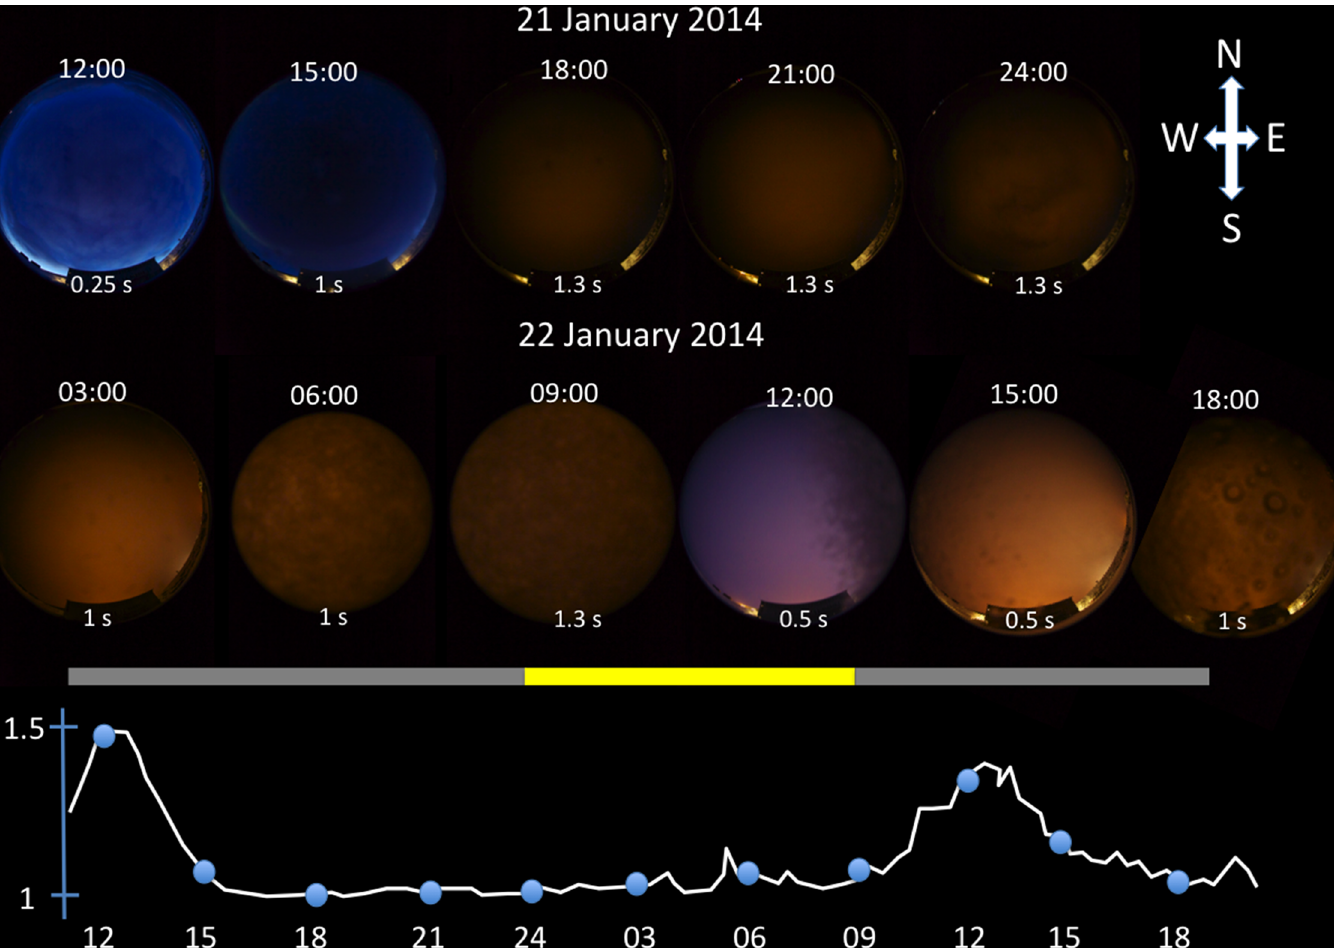
Fig 1. All-sky pictures from Ny- Å lesund 21st and 22nd of January 2014. Time of day is indicated on each picture and corresponds to a blue circle on the graph (bottom; E PAR , 400 – 700 nm, Photosynthetic Active Radiation) showing the absolute value of ambient light at that point in time in units of x10 -5 μ mol photons m -2 s -1 . The rectangular bar indicates the time of day when the moon is below (grey) and above (yellow) the horizon, and aligned with the time-scale on the irradiance graph below. On each picture the exposure time is given — all pictures were taken with the same ISO setting. The time-lapse camera and the light sensor were located next to each other